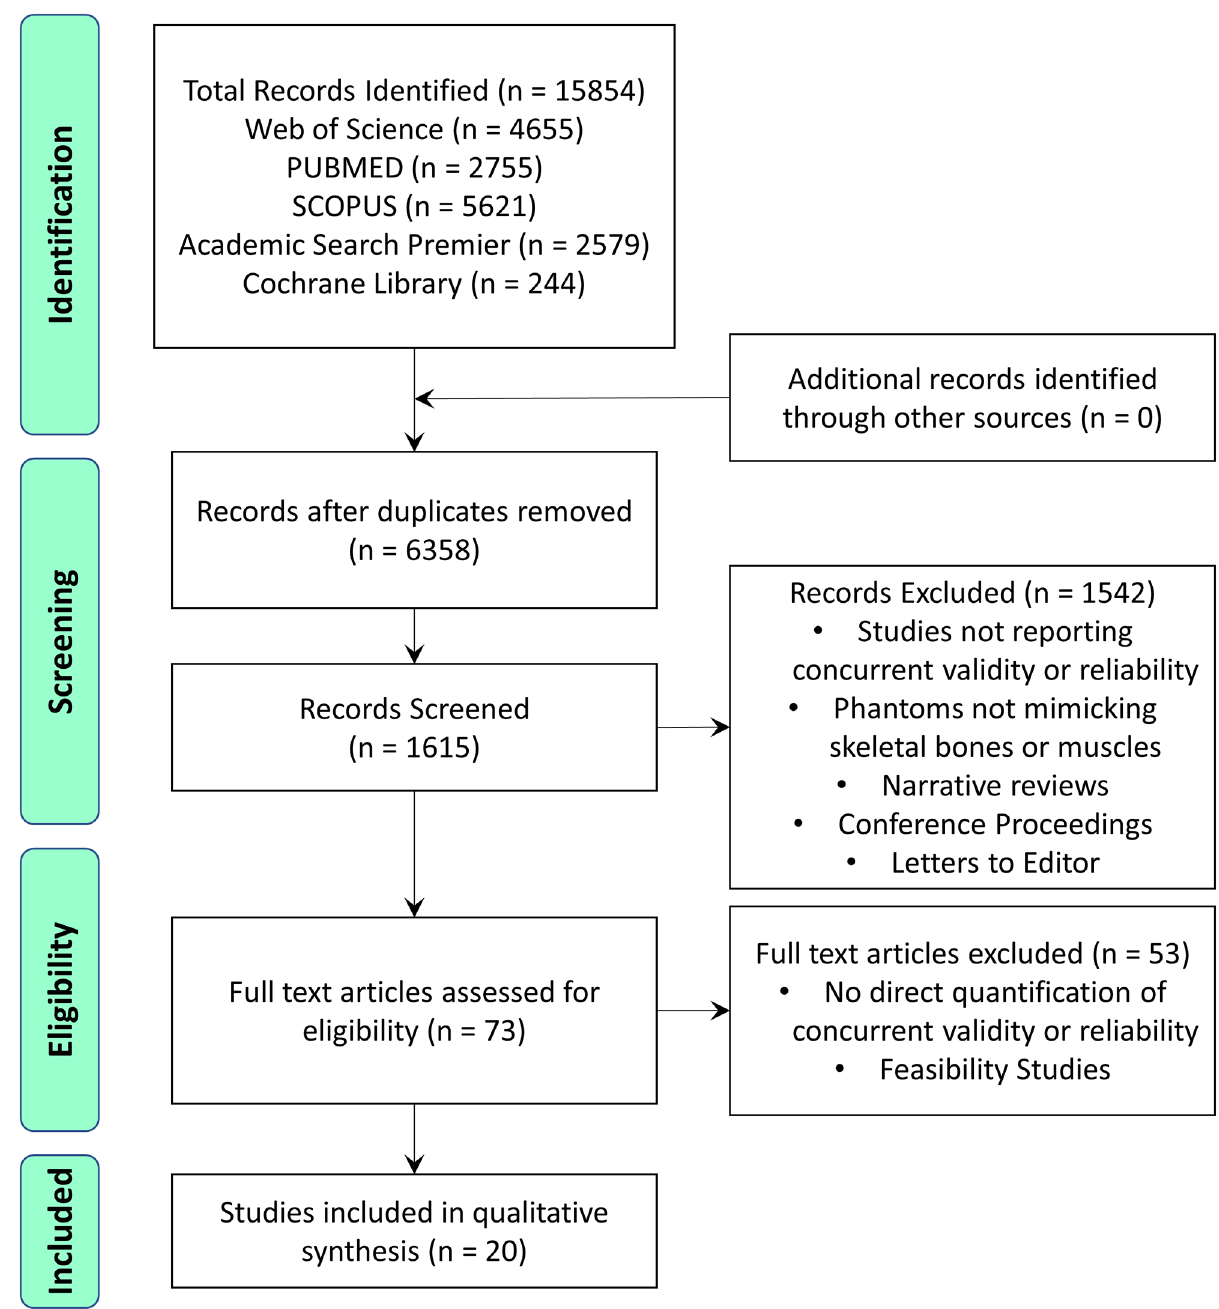
Fig 1. Flow chart of study